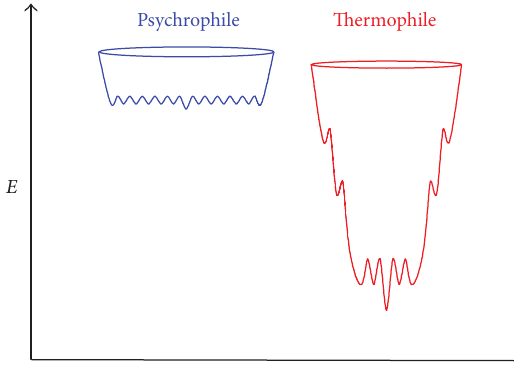
F 13: Folding funnel model of enzyme temperature adap- tation. In these schematic energy landscapes for extremophilic enzymes, the free energy of folding ( E ) is depicted as a function of the conformational diversity. e height of the funnels is deduced from the determination of the conformational stabilities. e top of the funnels is occupied by the unfolded states in the numerous random coil conformations, whereas the bottom of the funnels corresponds to native and catalytically active conformations. e ruggedness of the bottom depicts the energy barriers for intercon- version, or structural �uctuations of the native state